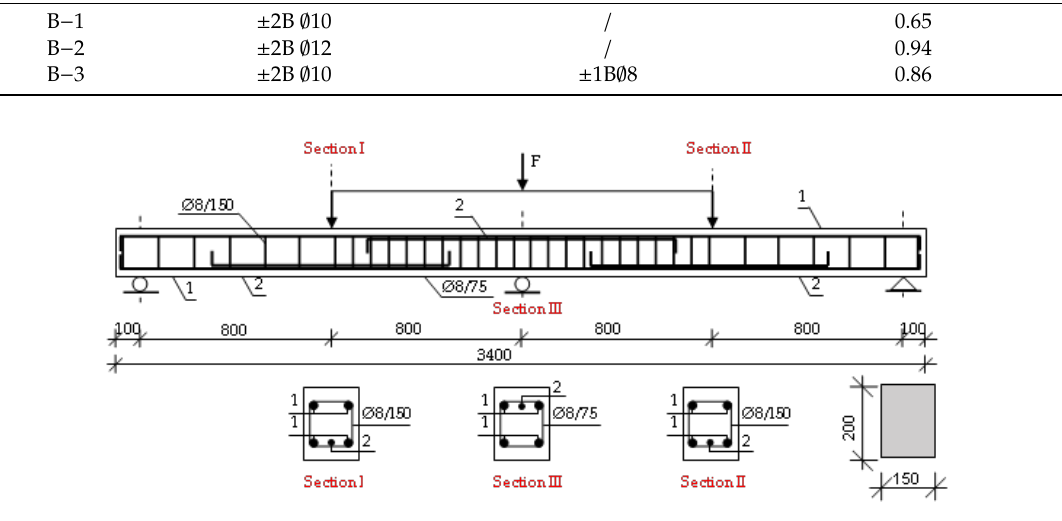
Figure 3. Reinforcing of the tested beams.